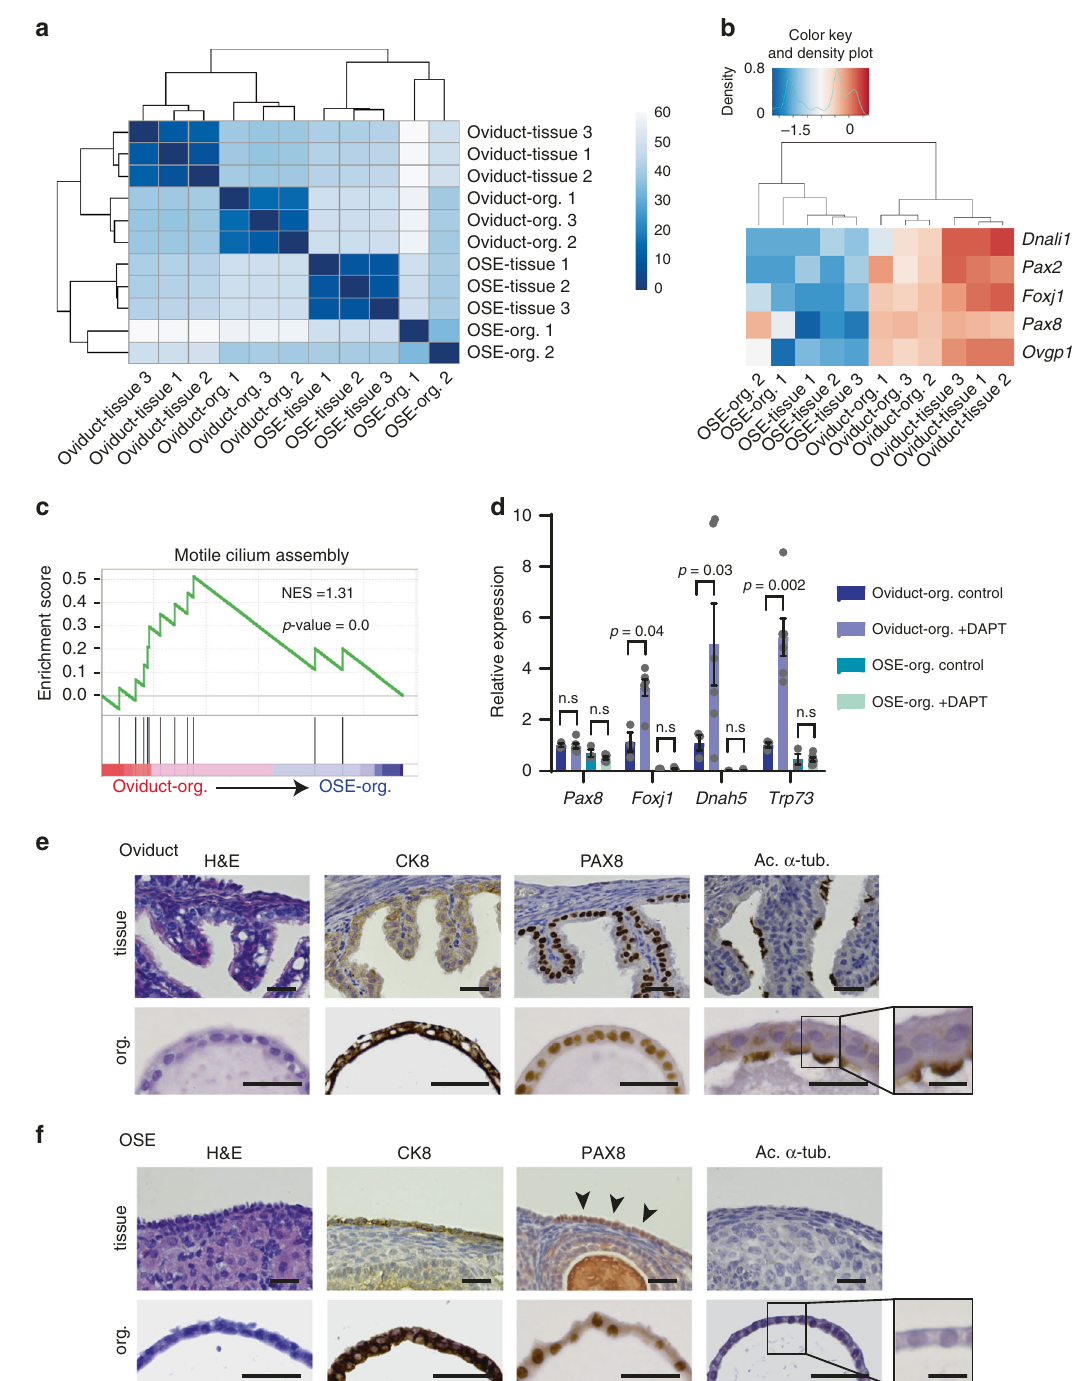
Fig. 2 Characterization of healthy oviductal and OSE organoids. a Sample-to-sample heatmap showing the Euclidean distances between the organoids and parental bulk tissues as calculated from the regularized log transformation. Correlation is based on the top 500 differentially expressed genes between the organoid lines and the pseudocolor scale shows hierarchical distance from minimum (0, dark blue) to maximum (60, white). b Heatmap depicting known oviductal marker genes and their expression in the oviductal and OSE organoids and tissues. c Gene set enrichment analysis (GSEA) showing strong enrichment of genes involved in motile cilium assembly in oviductal organoids compared with OSE organoids. NES: normalized enrichment score, p -value is a permutation-based p -value that is computed and corrected for multiple testing ( n = 3 oviductal and n = 2 OSE biologically independent organoid lines for each group). d qPCR results showing upregulation of selected genes ( Foxj1 , Dnah5, Trp73 ) involved in ciliogenesis in oviductal organoids upon treatment with NOTCH pathway inhibitor (DAPT) for 2 weeks. Assay was performed in n = 3 biologically independent replicates over three independent experiments. Error bars represent ±SEM. Statistical signi fi cance was calculated by two-tailed Student ′ s t -test, n.s — not signi fi cant. e Histological stainings of oviduct tissue and corresponding organoids ( n = 4 independent experiments). The organoids are positive for epithelial marker CK8 and show presence of both PAX8-positive secretory and acetylated α -tubulin-positive ciliated cells. Scale bar, 25 μ m; scale bar of the inset, 10 μ m. f Histological stainings of OSE tissue and corresponding organoids ( n = 4 independent experiments). OSE-derived organoids are positive for CK8 and PAX8, but lack ciliated cells. Scale bar, 25 μ m; scale bar of the inset, 10 μ m. a – f OSE — ovarian surface epithelium, Org. —